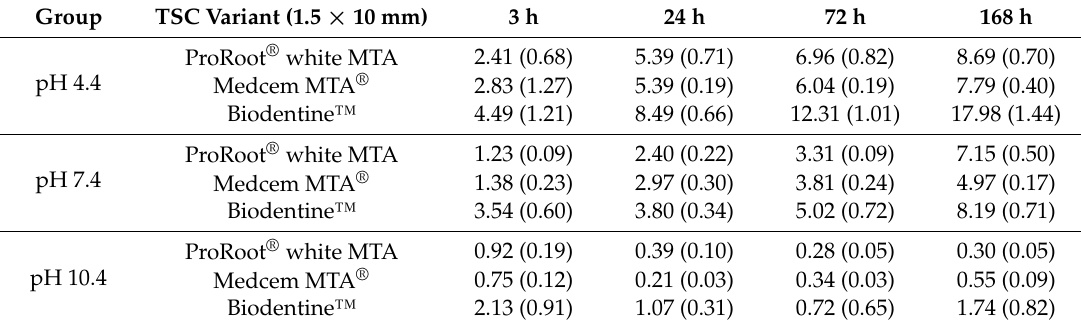
respectively. Table 2. Amount of calcium ions released (in μmol) by the TSCs as a function of sample dimensions (varying Vol and ESA) with corresponding standard deviation ( n = 6) between parentheses at different time intervals.